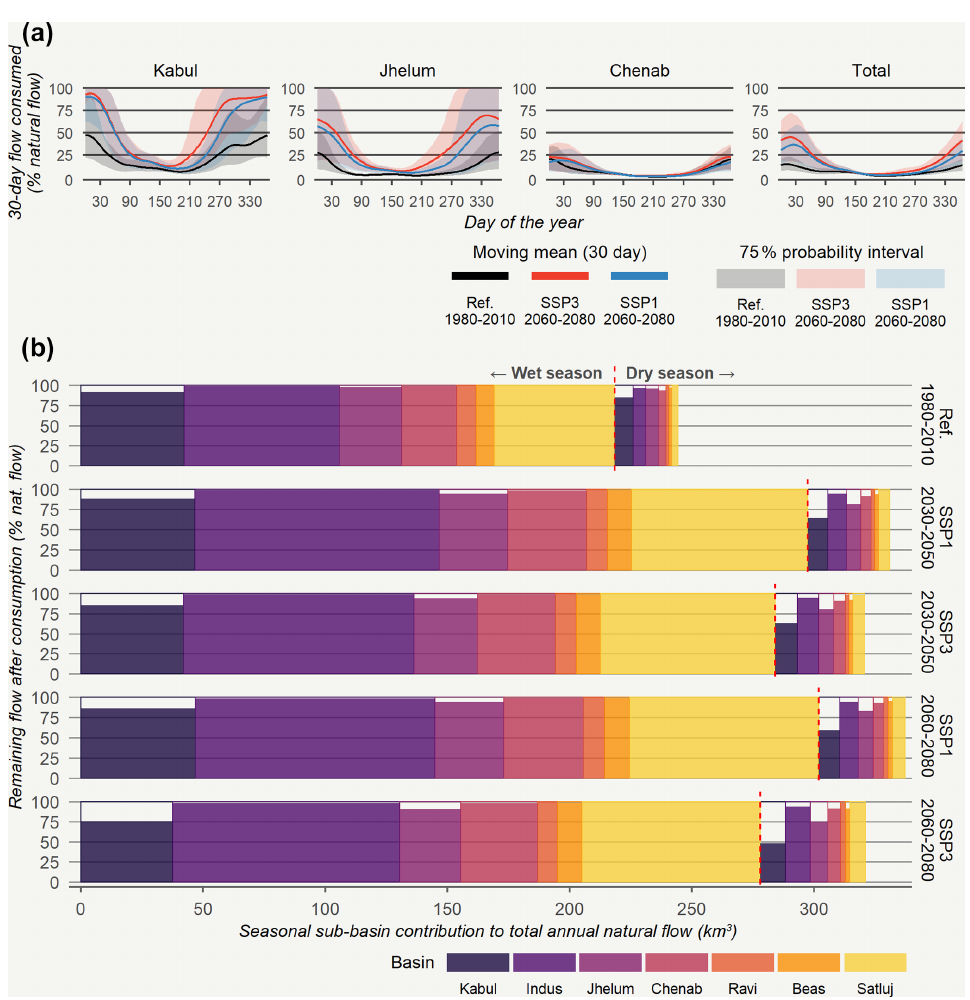
Figure 4. Daily share of natural flow consumed in the upper Indus sub-basins during the reference period and the projected Late time periods (a) . Development of ensemble mean absolute upper Indus outflow under climate change and the impact of consumption (b) .